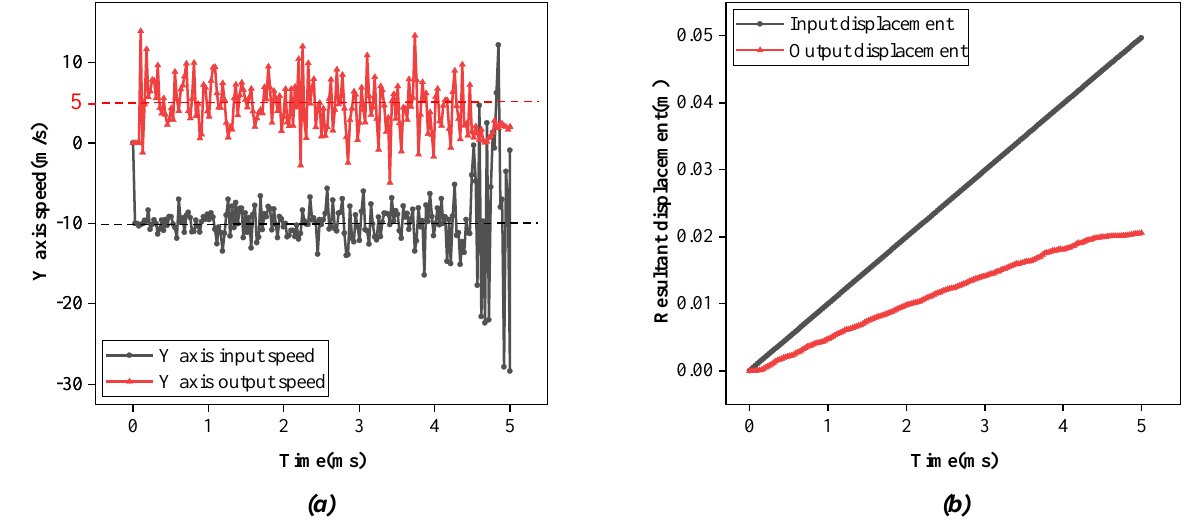
Figure 9. Simulation analysis curve of lasso movement speed and displacement. ( a ) Speed-time curve; ( b ) Displacement-time curve.